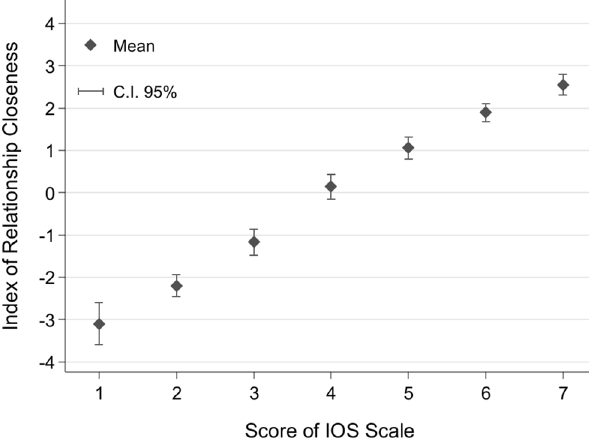
Fig 2. The link between the Index of Relationship Closeness and IOS. ‘ The Index of Relationship Closeness ’ is the principal component of five measurements of the closeness of relationships: RCI and SCI [12], We Scale [22], Loving and Liking Scale [13], and PAM Scale